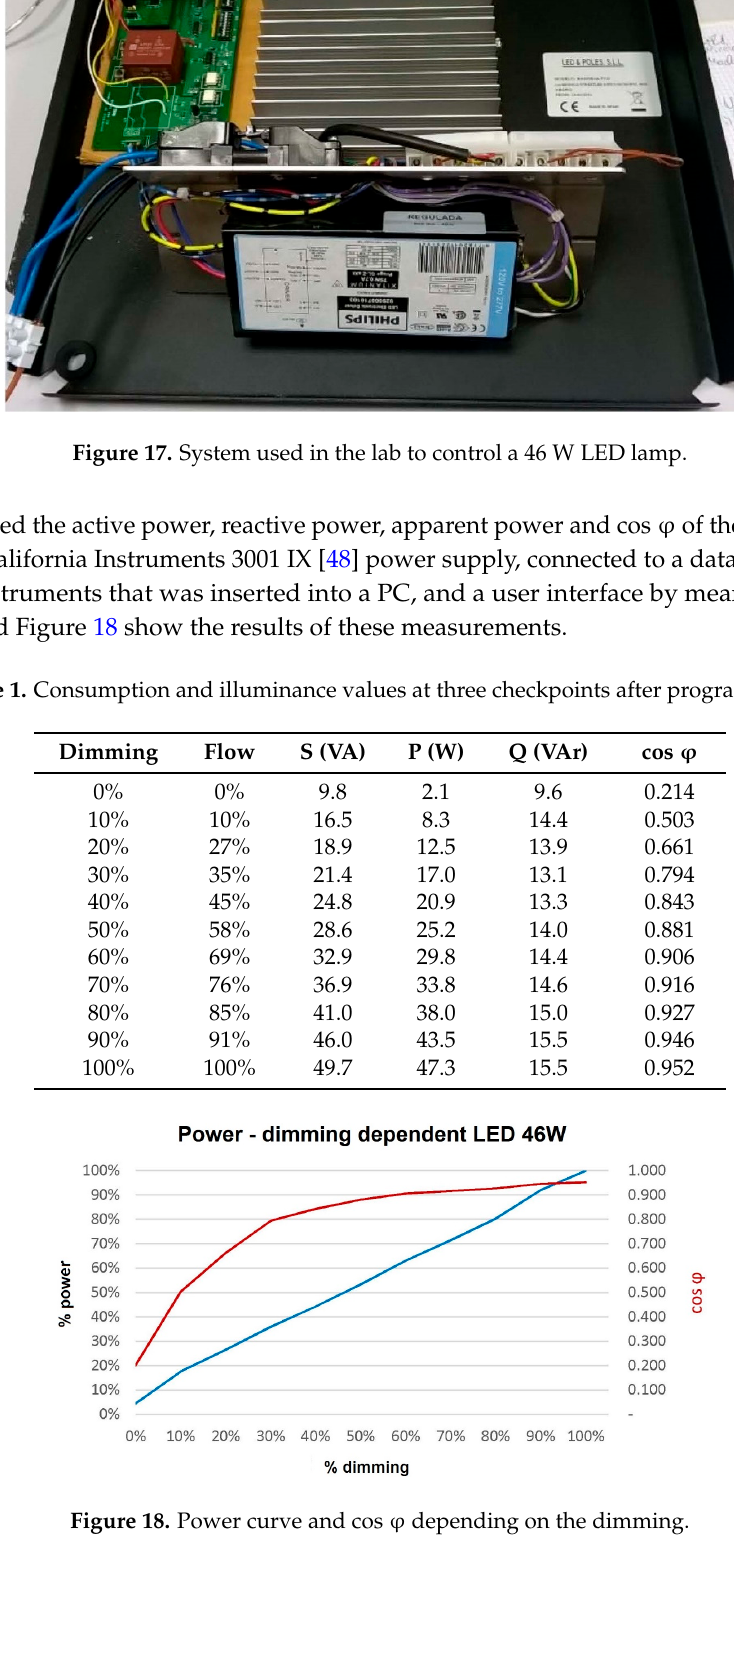
Figure 18. Power curve and cos ϕ depending on the dimming.